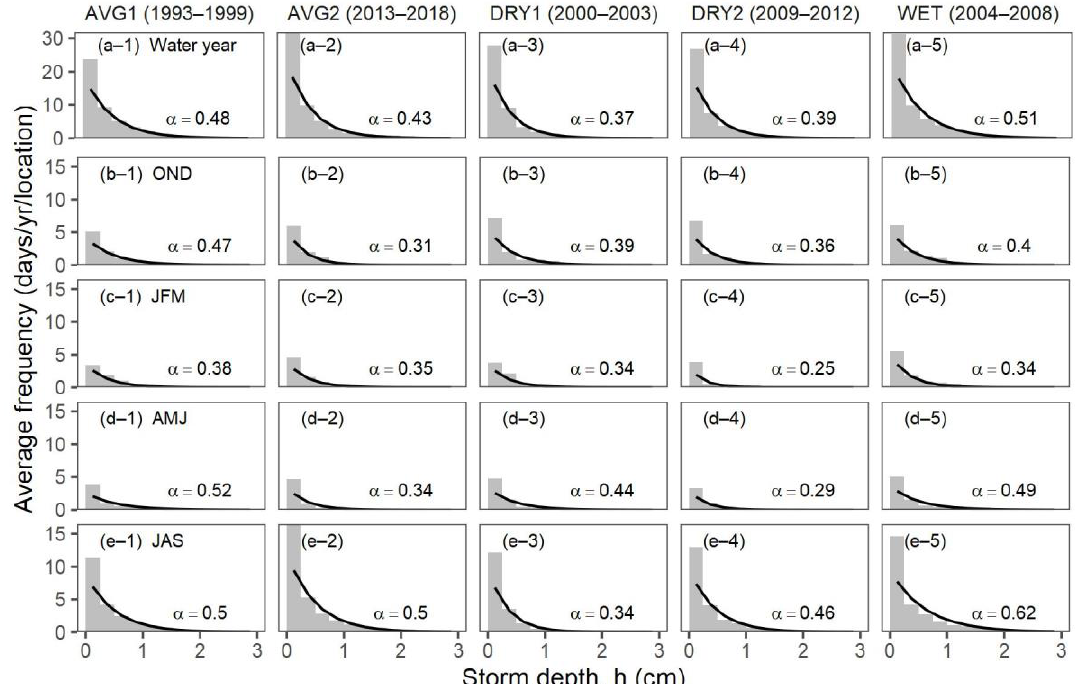
Figure 3. Storm depth distributions (bars; relative number of days/yr/location) and fitted exponential PDFs (curves) for depths ≥ 3 cm with a bin size of 0.25 cm. Only nonzero precipitation is shown. Relative frequency for each season and period was calculated using bin frequency from all 16 locations and number of years in the period divided by 16 and the number of years. PDF curves (probability density) are vertically-scaled to match the average frequencies. Vertical scale differs by row. Row ( a ) is water year, row ( b ) is fall, row ( c ) is winter, row ( d ) is spring, and row ( e ) is summer.